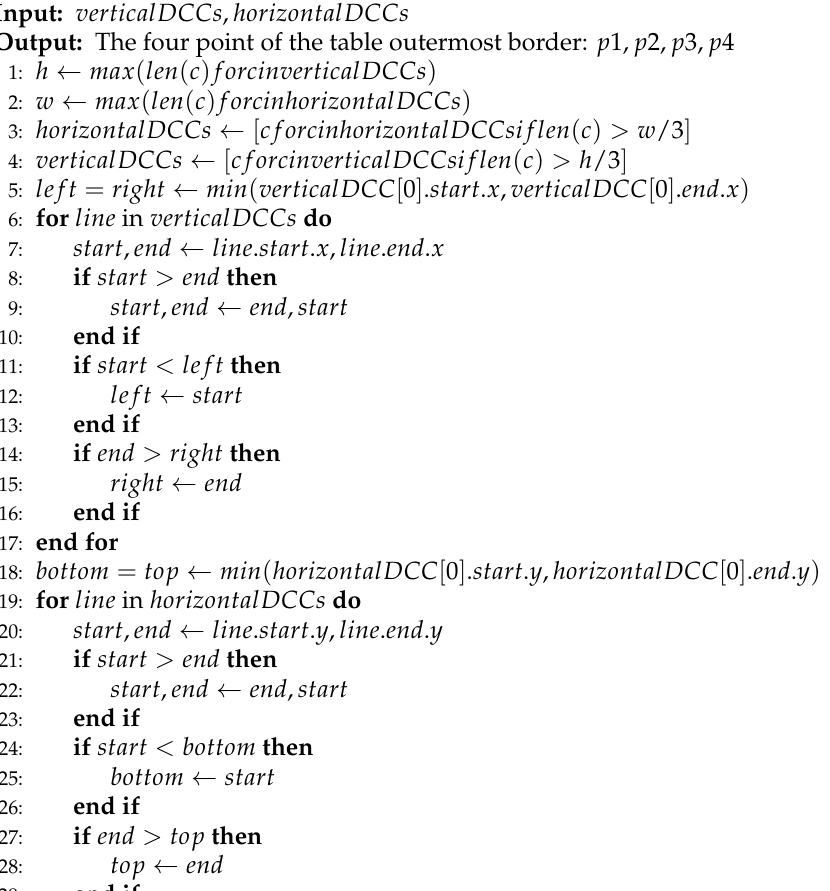
Algorithm 1 Table outermost border